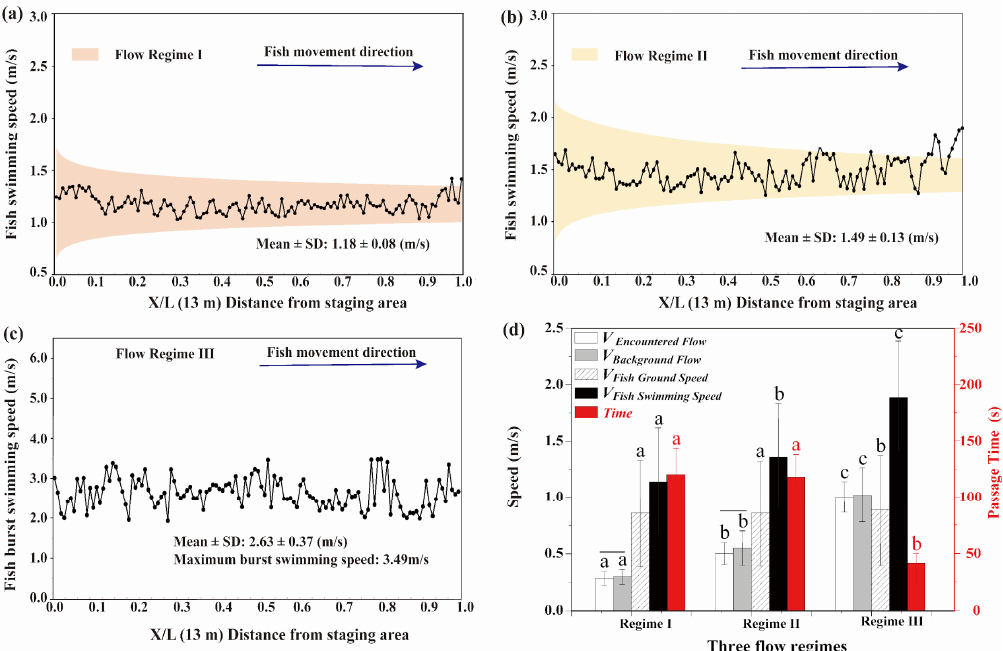
Figure 8. The relationship between the average and 95% confidence intervals of fish swimming speed (m/s) with movement distance in ( a ) regime I and ( b ) regime II, and the maximum burst swimming speed in ( c ) regime III; ( d ) encountered flow (m/s), background flow (m/s), fish ground speed (m/s), fish swimming speed (m/s), and passage time in the different flow regimes, with the difference in the same variable indicated by different letters (a, b, and c), and the difference between the encountered flow and background flow indicated by the black solid line.